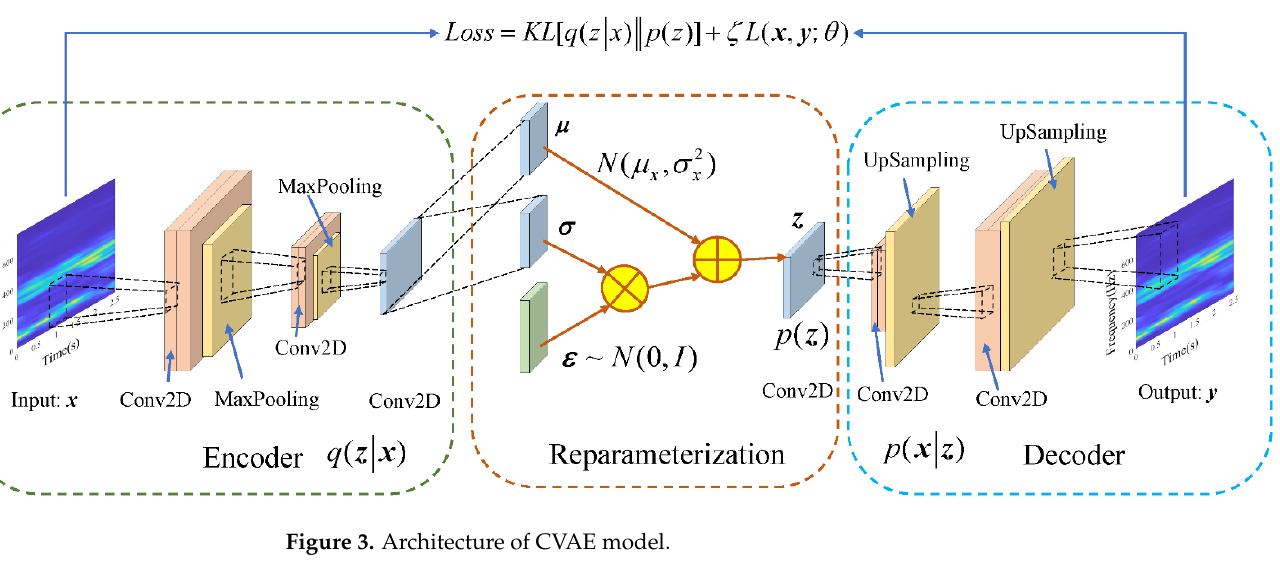
Figure 3. Architecture of CVAE model.